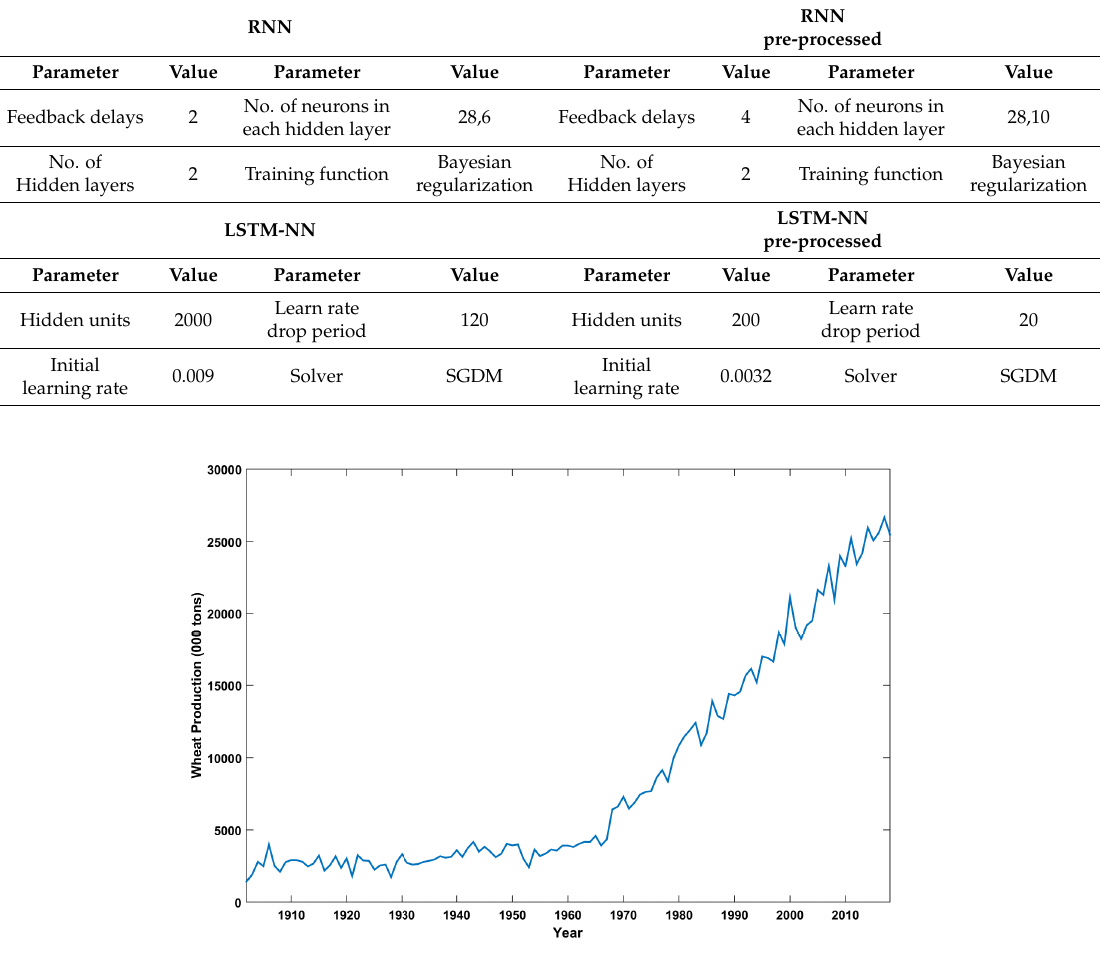
Figure 5. Historical wheat production of Pakistan from 1902–2018.